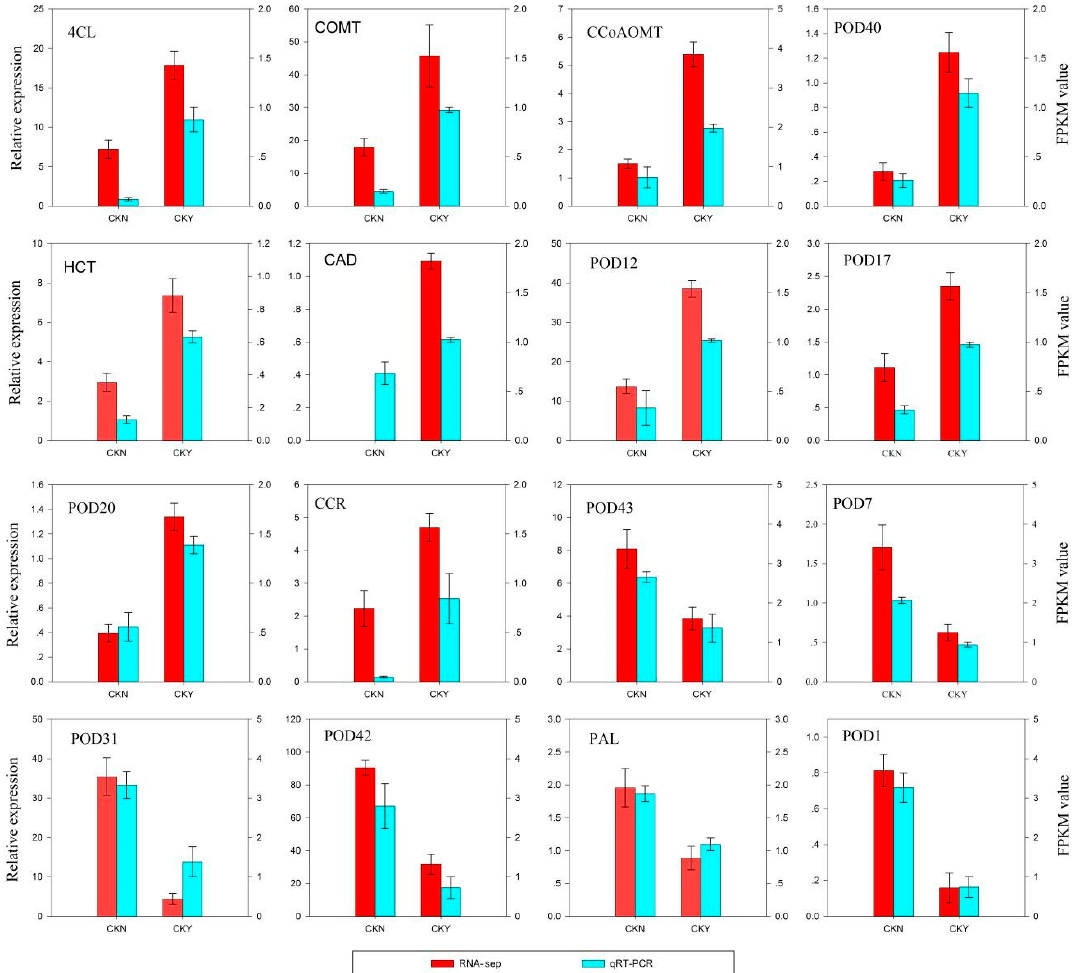
Figure 4. qRT-PCR validation of RNA-seq data. The left y -axis shows the relative gene expression levels as assessed by qRT-PCR and the right y -axis indicates the corresponding RNA-seq expression data. Each value in the histogram represents the mean ± standard error. CKN and CKY indicate non-russet and russet peel samples, respectively. 4 coumarate CoA ligase, 4CL , ca ff eic acid 3- O -methyltransferase, COMT , cinnamyl alcohol dehydrogenase, CAD , shikimate O -hydroxycinnamoyl transferase, HCT , ca ff eoyl-CoA O -methyltransferase, CCoAOMT , peroxidase, POD , cinnamoyl-CoA reductase, CCR , and phenylalanine ammonia-lyase, PAL .